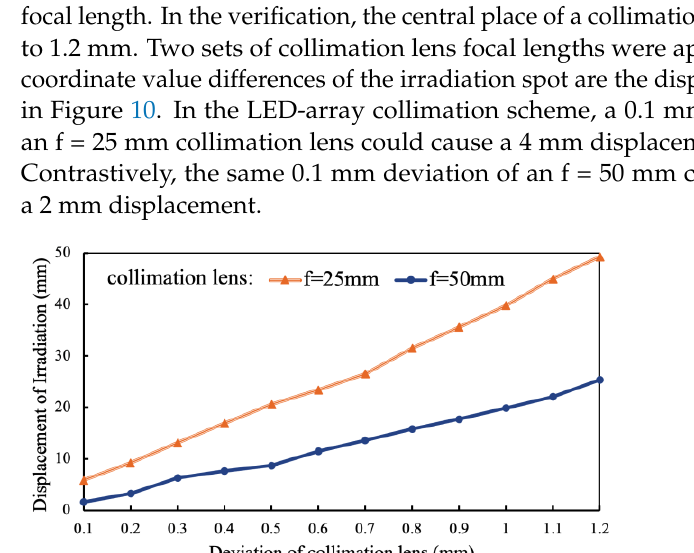
Figure 10. Displacement of irradiation place caused by lens deviation.